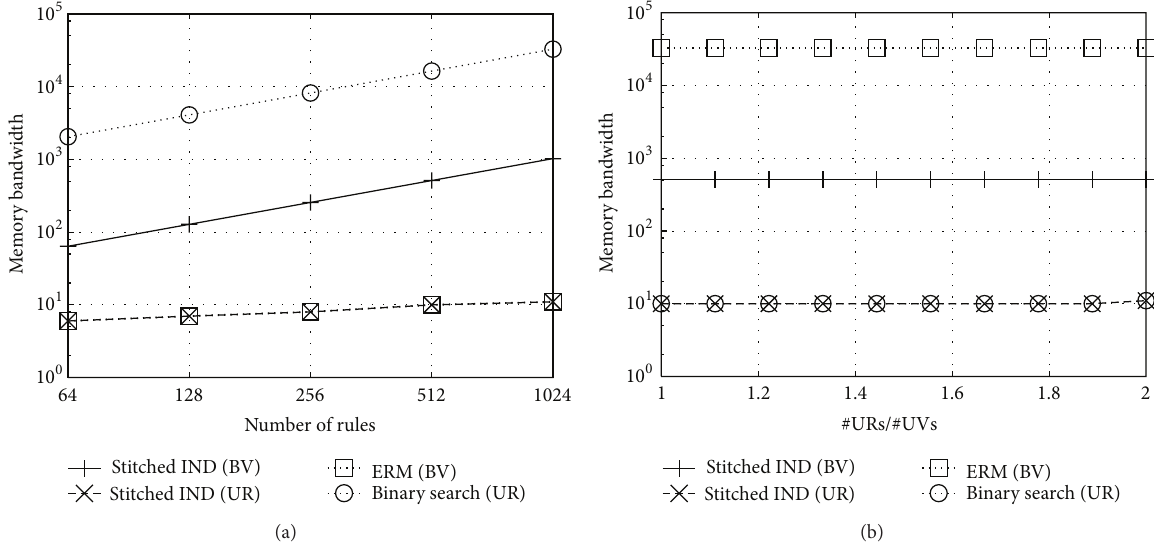
Figure 22: Memory bandwith: (a) | UR | = | UV | = 𝑁 , 64 ≤ 𝑁 ≤ 1024 and (b) | UV | = 𝑁 = 512 , | UV | ≤ | UR | ≤ 2 ⋅ | UV | .